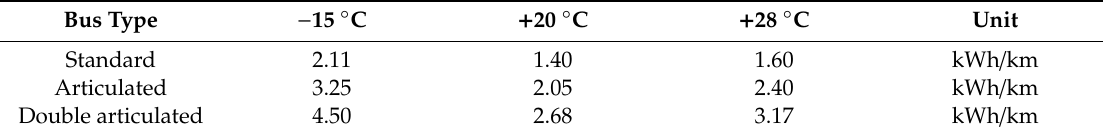
Table 1. Energy consumption of electric buses in dependence on the ambient